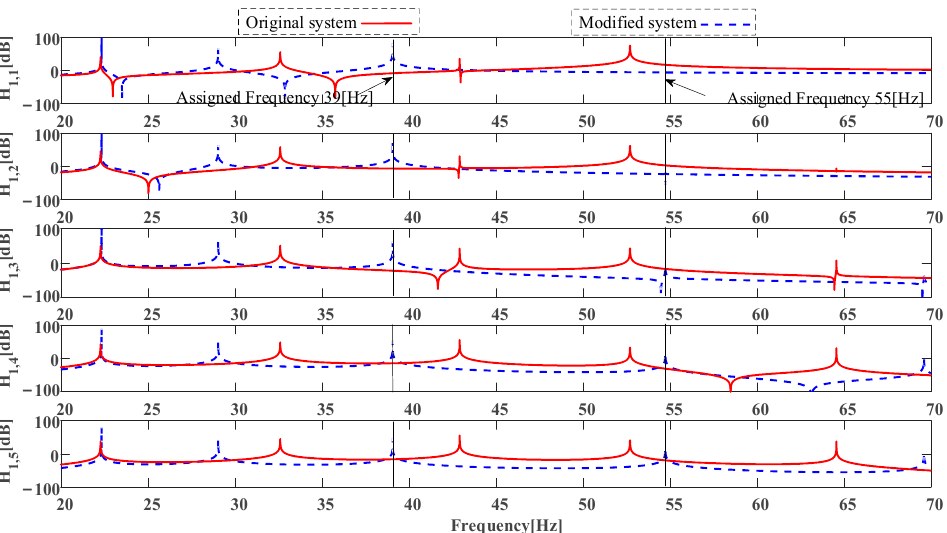
Figure 28. Original FRFs and FRFs after the simultaneous addition of masses and supporting stiffness. Table 20. Comparison of natural frequencies and mode shapes.